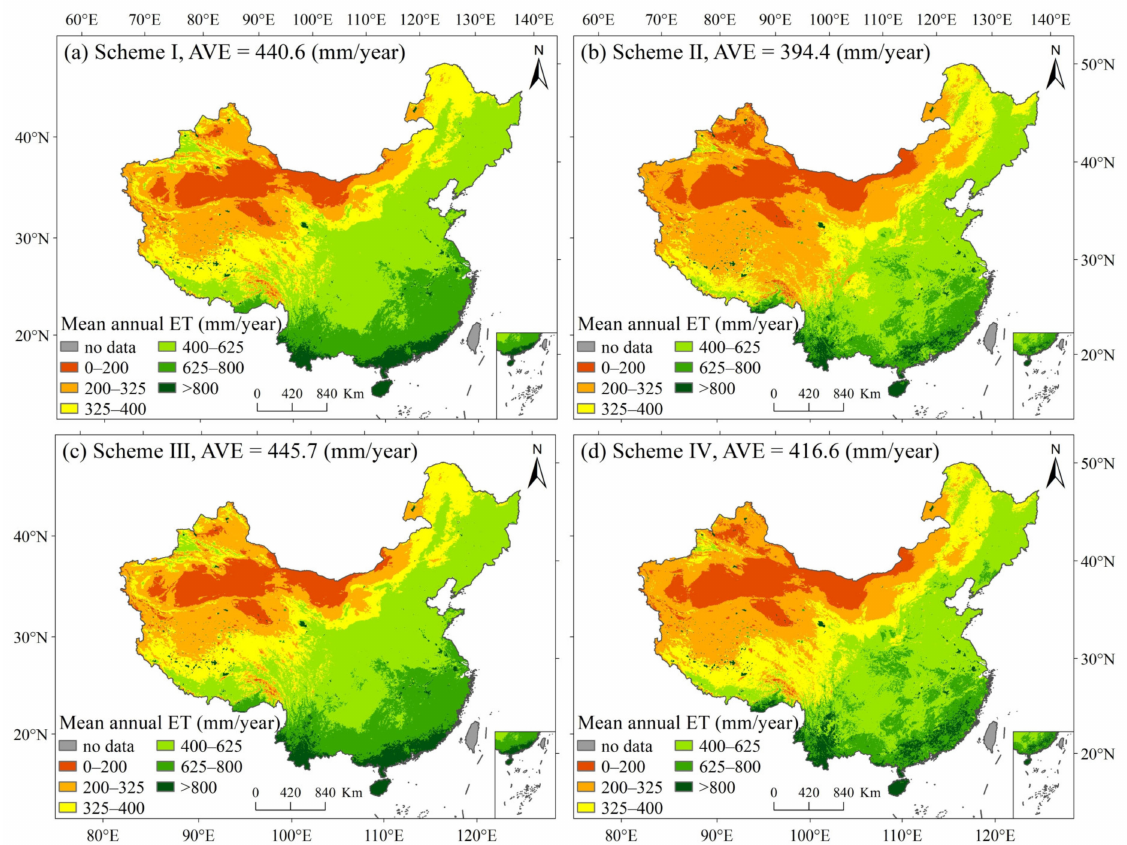
Figure 5. The spatial pattern of mean annual (1982–2015) ET estimates from the PT-JPL model under four vegetation input schemes. AVE: National average.